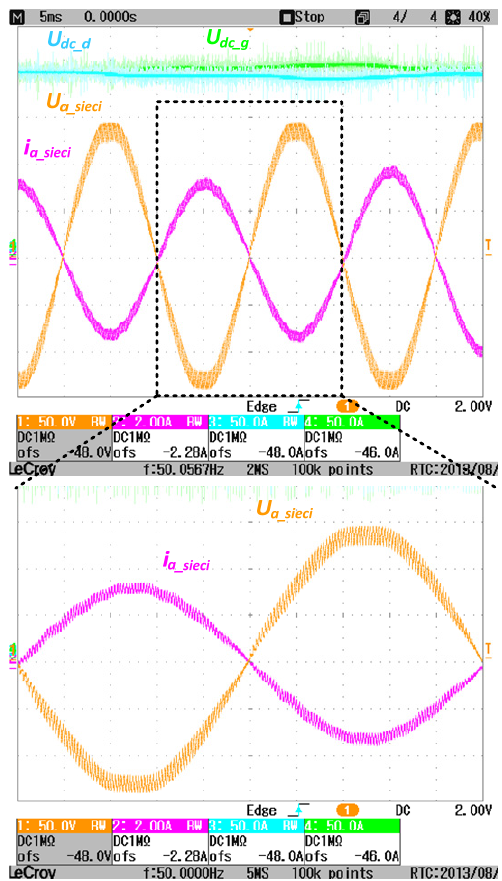
Fig. 9. Steady state of single-phase DC/AC part of converter at grid connected mode of operation. From top: voltage on upper capacitor ( U dc_g ), voltage on lower capacitor ( U dc_d ),grid voltage ( U a_sieci ) and grid current ( i a_sieci ).